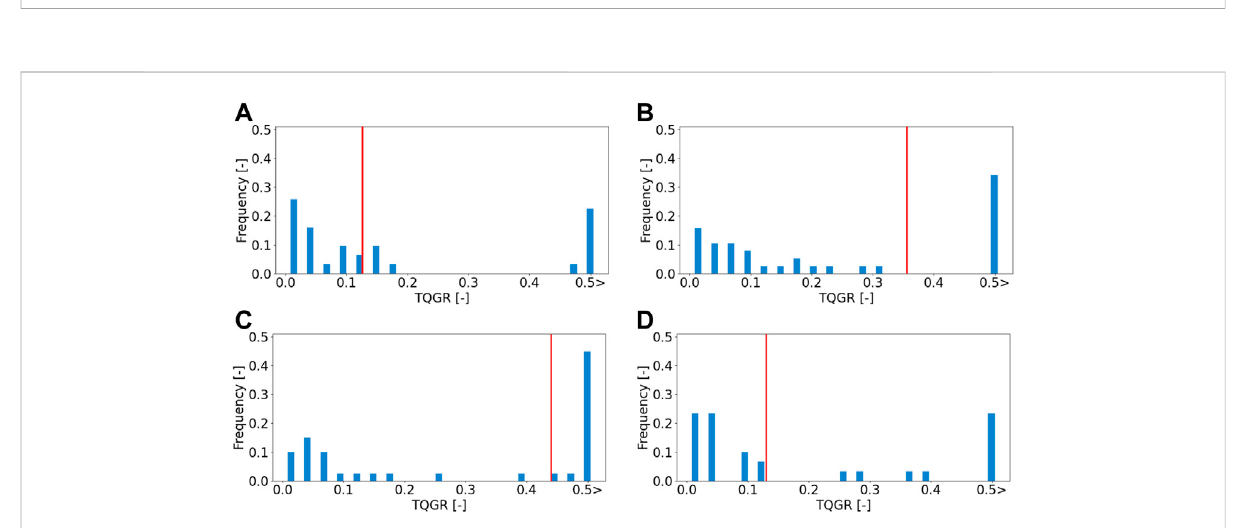
FIGURE 11 Histogram of the TQGRs for each terrain. Red lines show the geometric mean of TQGRs. (A) Flat terrain: roughness 0.083 m, (B) Rocky terrain: roughness 0.123 m, (C) Rough terrain: roughness 0.234 m, (D) Sloped terrain: roughness 0.257 m.